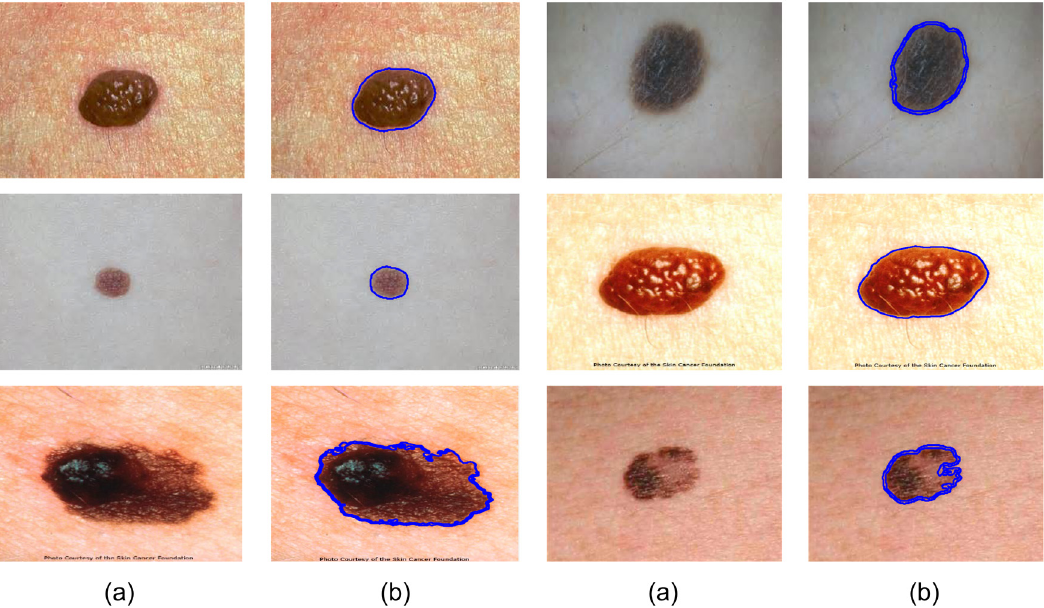
Figure 4: The results of cancer diagnosis for some examples by the SBO - based CNN. ( a ) before process, ( b ) after